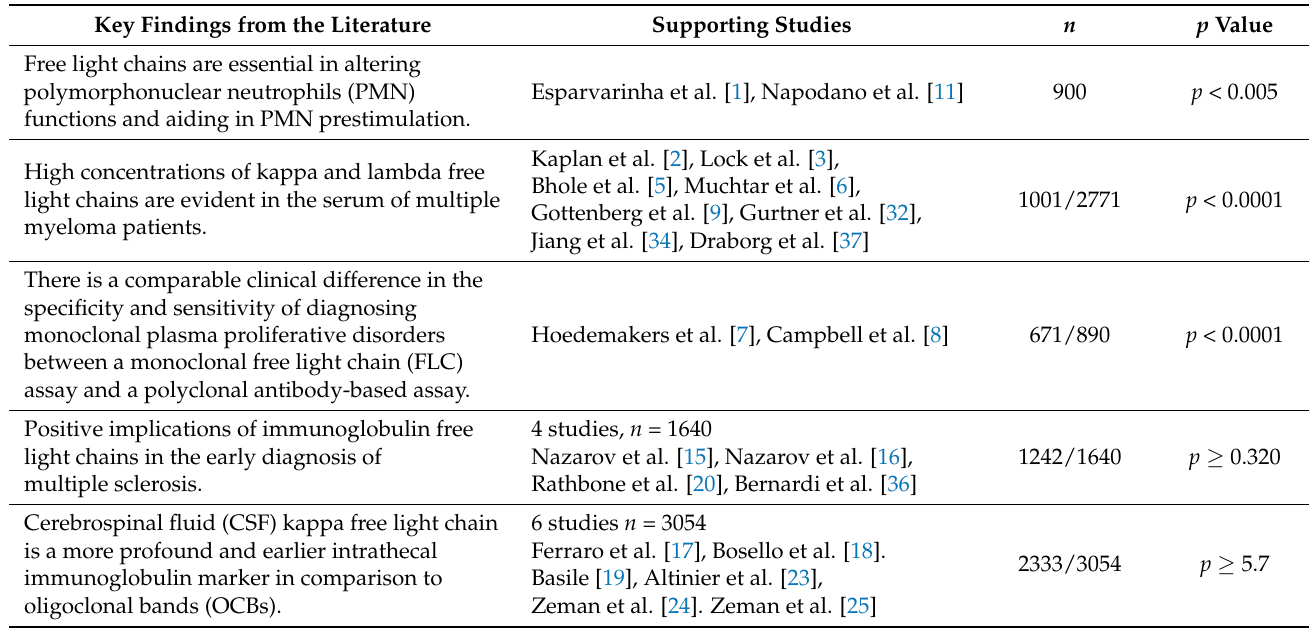
Table 1. Significant Findings about the Efficiency of Free Light Chain Testing in General and in Multiple Sclerosis